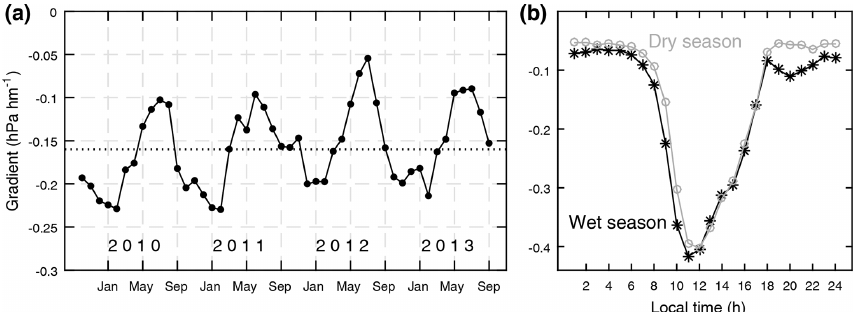
Figure 8. (a) Mean monthly water vapor pressure gradient (dotted line indicates the 4-year mean) and (b) its mean diurnal cycle for the climatological dry (JF, JJAS) and wet (MAM, OND) seasons in grey and black, respectively, between 8 October 2009 and 30 September 2013. Note the different y -axis scaling.